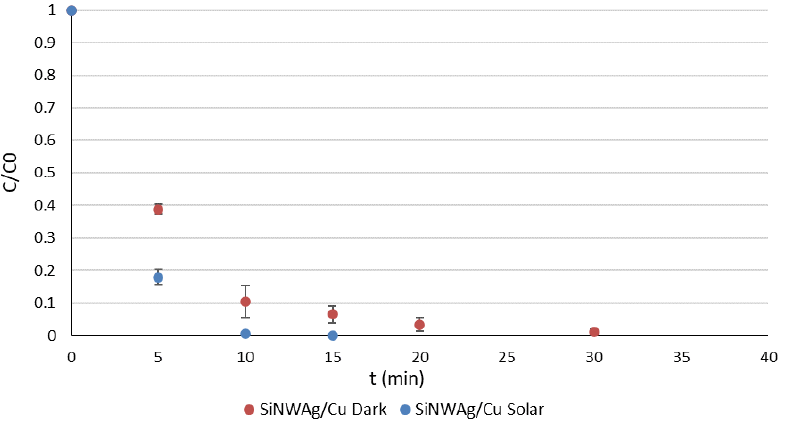
Figure 10. Triplicates of C 0 = 15 mg/L Cr(VI) reduction, in the presence of 25 mM citric acid and 1.2 g catalyst/L, under simulated solar irradiation and dark conditions, at pH 2.4.